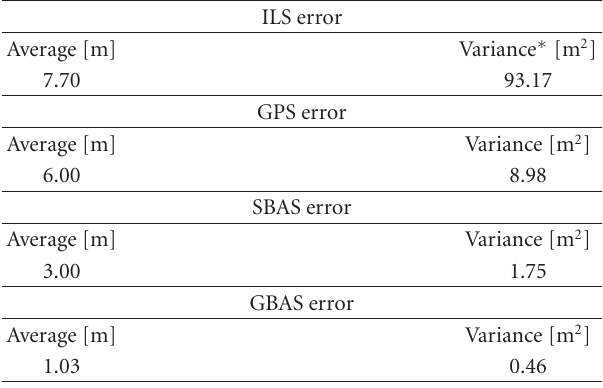
Table 1: Sensor global accuracy error budget expressed in terms of average ε and variance σ 2